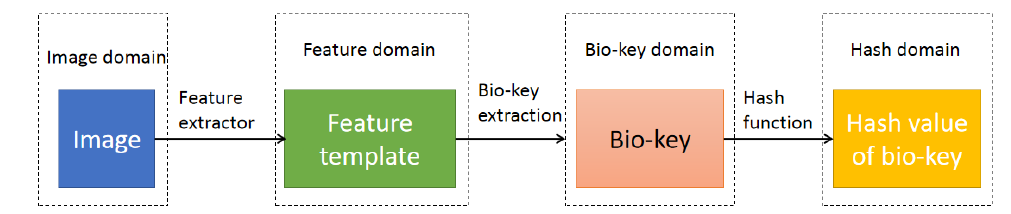
Figure 5. Biocryptosystem framework.